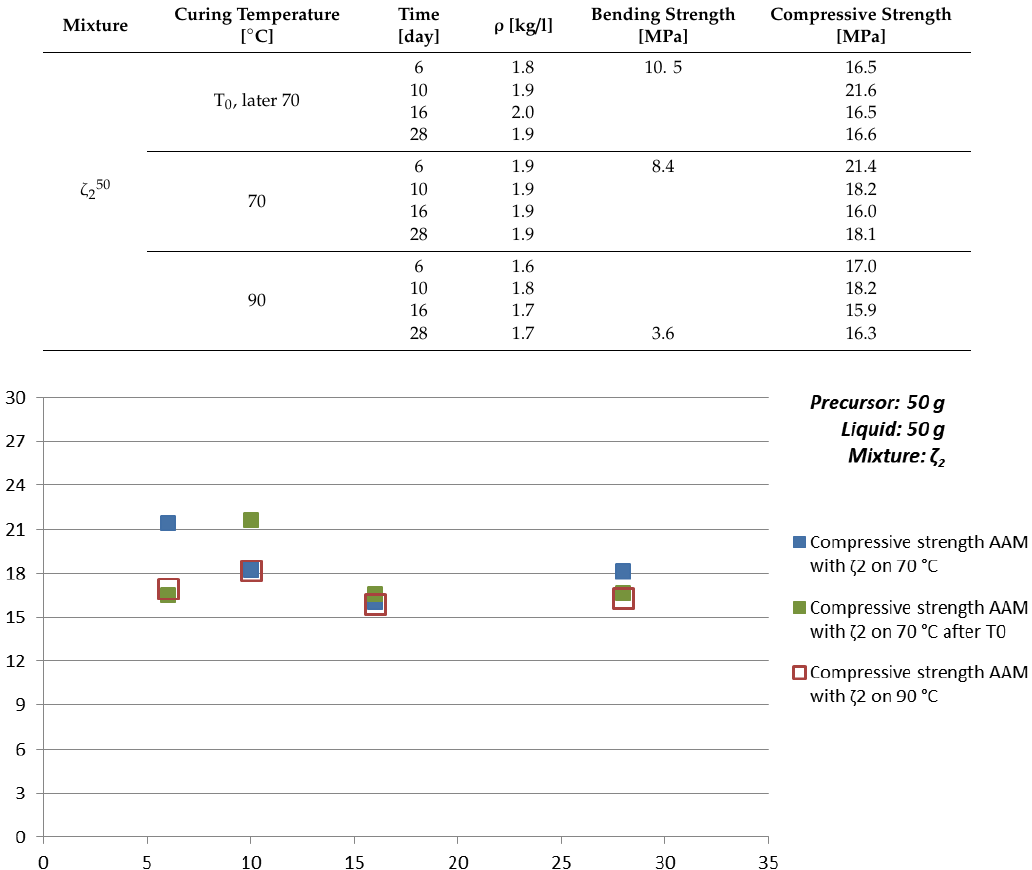
Table 11. Time dependence of density, bending, and compressive strength of AAM prepared with mixture ζ 5 , cured on 70 °C for one day and cured on 90 °C for one day.